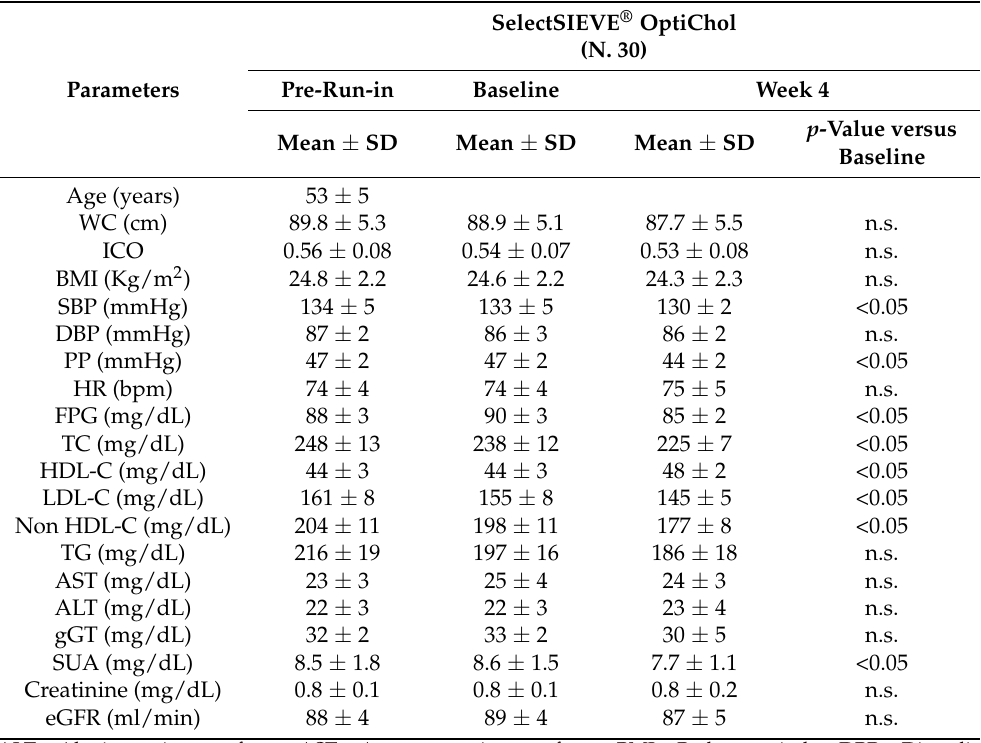
Table 3. Anthropometric, hemodynamic, and blood chemistry parameters from the baseline to the end of the clinical